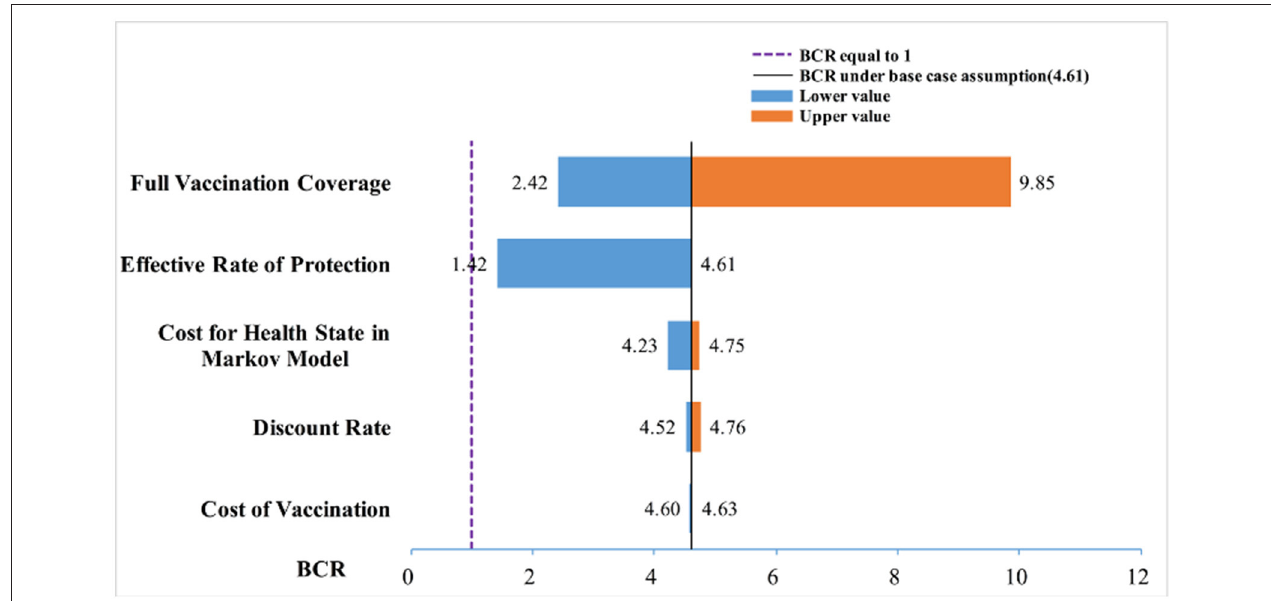
FIGURE 3 | Tornado diagram for the one-way sensitivity analysis for the